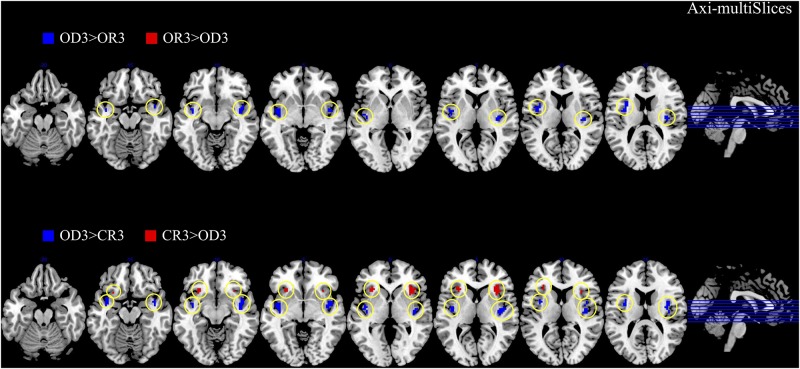
The anterior and posterior insular activations observed after the application of creative reappraisals (CR) and objective descriptions (OD) (transverse plane).